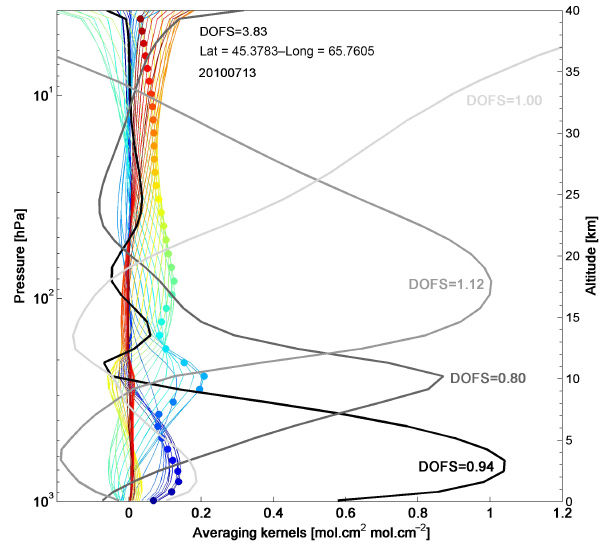
Figure 1. Typical IASI FORLI-O 3 averaging kernels, in partial col- umn units, corresponding to one mid-latitude observation in July (45 ◦ N/66 ◦ E) for each 1km retrieved layers from ground to 40km altitude (colour scale) and for four merged layers: ground–300hPa; 300–150hPa; 150–25hPa; 25–3hPa (grey lines). The total DOFS and the DOFS for each merged layers are also